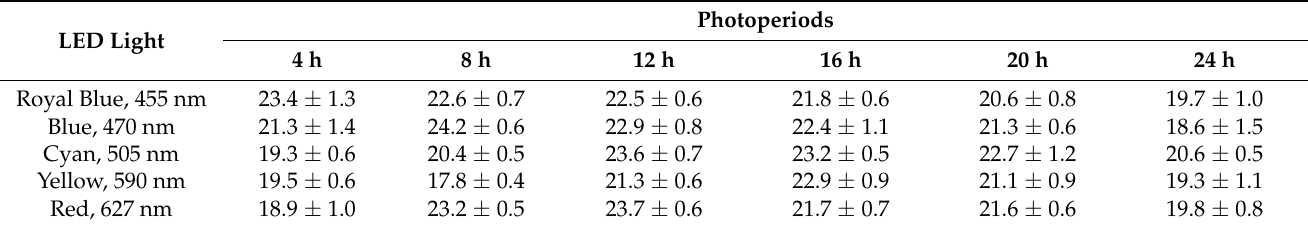
Table 1. The mycelial growth curve (AUMGC) of Botrytis cinerea under different wavelengths and photoperiods. LED Light